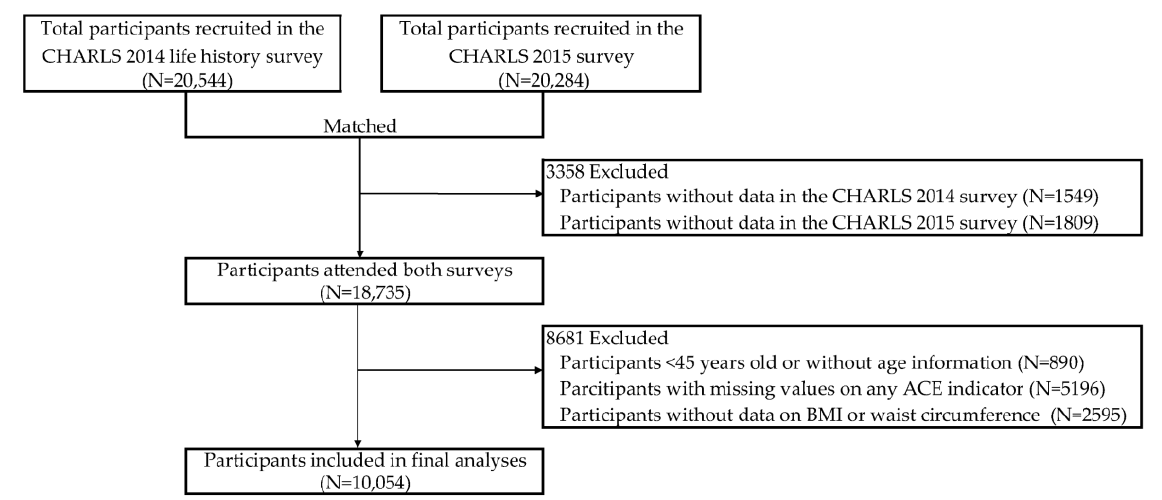
Figure 1. Study flowchart of participant selection.